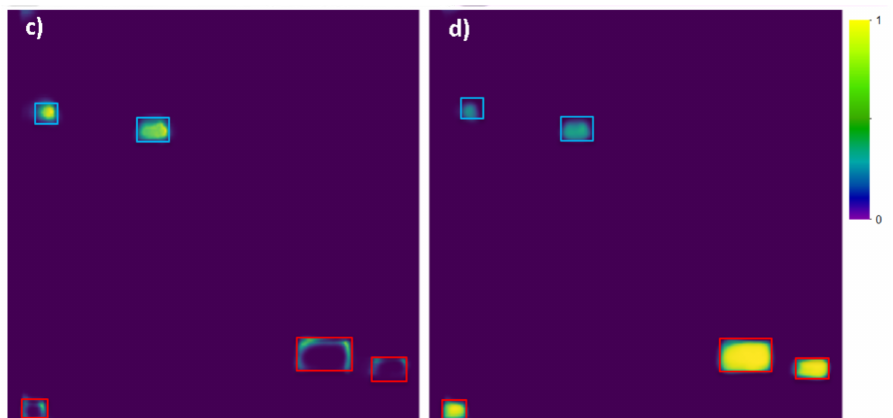
Figure 5. An example of the network’s probability prediction: Boxes in red and blue are demolished and intact building labels, respectively. ( a ) Post-event imagery (input to the network). ( b ) Input label mask (ground truth); blue shows intact building labels and red shows demolished building labels. ( c) Network predictions for the intact building class. ( d ) Network predictions for the demolished building